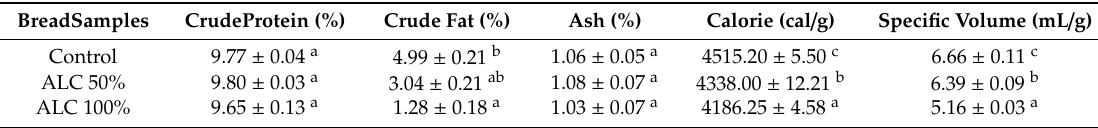
Table 5. Approximate composition of amylose-lipid complex-containing bread. BreadSamples